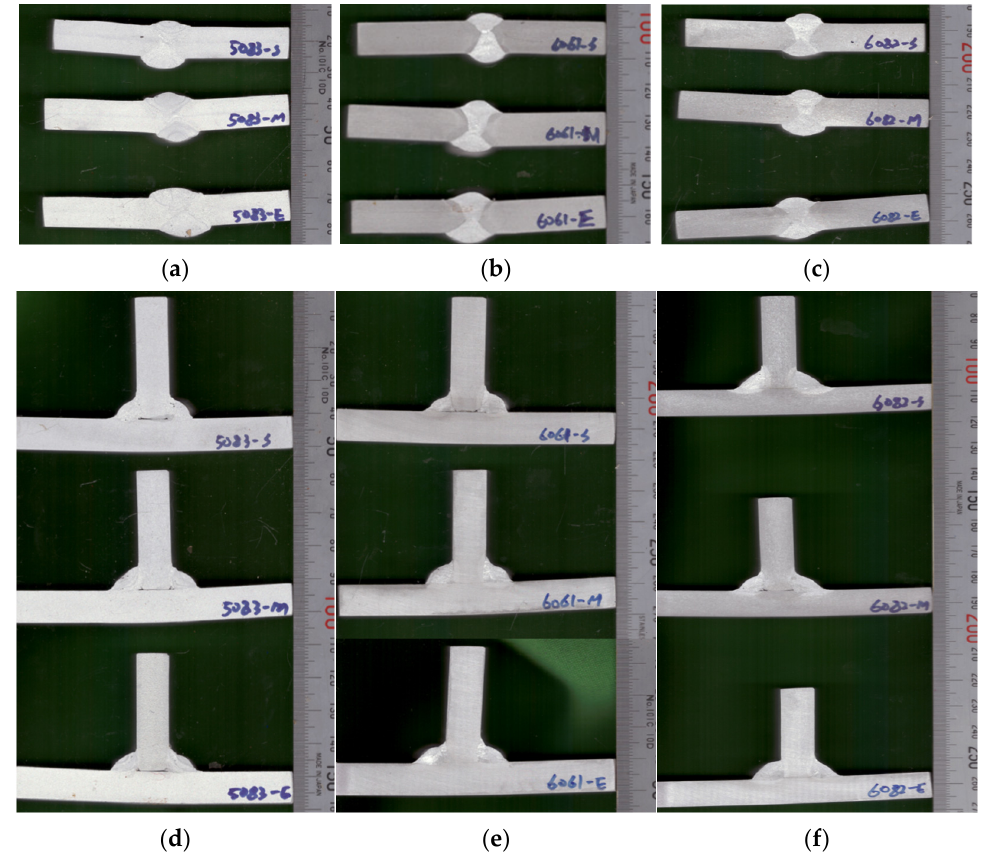
Figure 9. Macro section of Al alloys as: ( a ) Al 5083 H321 for butt welding; ( b ) Al 6061 T6 for butt welding; ( c ) Al6082 T6 for butt welding; ( d ) Al 5083 H321 for fillet welding; ( e ) Al 6061 T6 for fillet welding; ( f ) Al 6082 T6 for fillet welding.